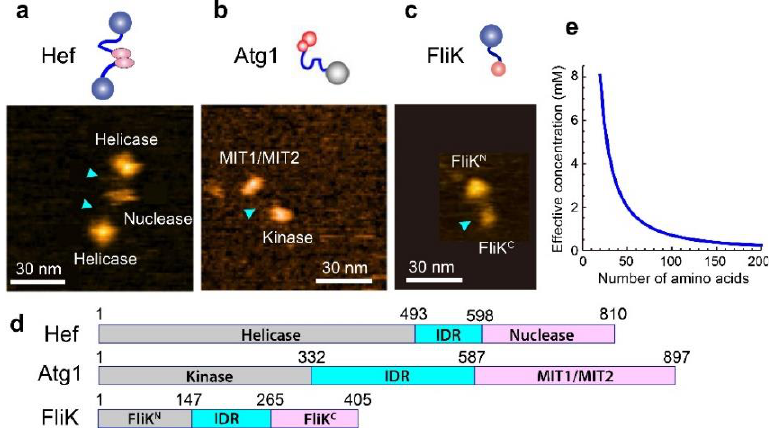
Figure 3. Dumbbell-shaped IDPs observed by HS-AFM. ( a – c ) Clips from HS-AFM images and their schematized molecular features of the three IDPs. The light blue arrowheads point to IDRs. ( d ) Domain diagrams of the three IDPs. ( e ) Effective concentration of CTD (NTD) around NTD (CTD) as a function of the number of amino acids contained in the fully disordered IDR connecting NTD and CTD.